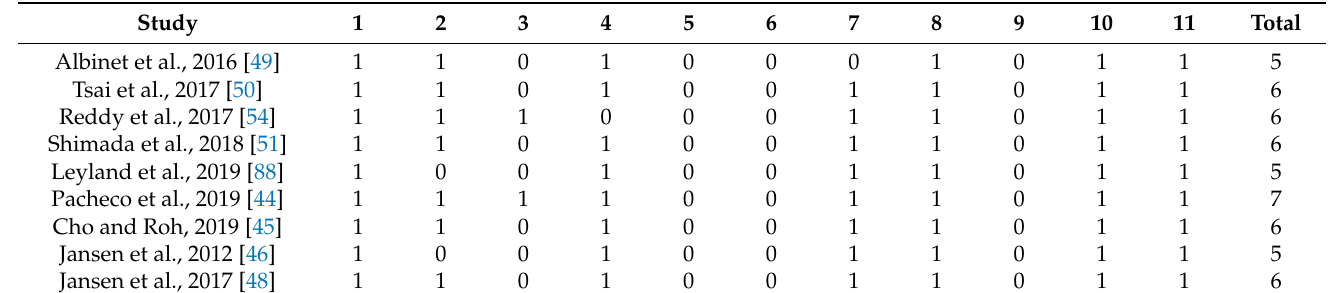
Table 4. PEDro scale of the studies included. PEDro: Physiotherapy Evidence Database scale.